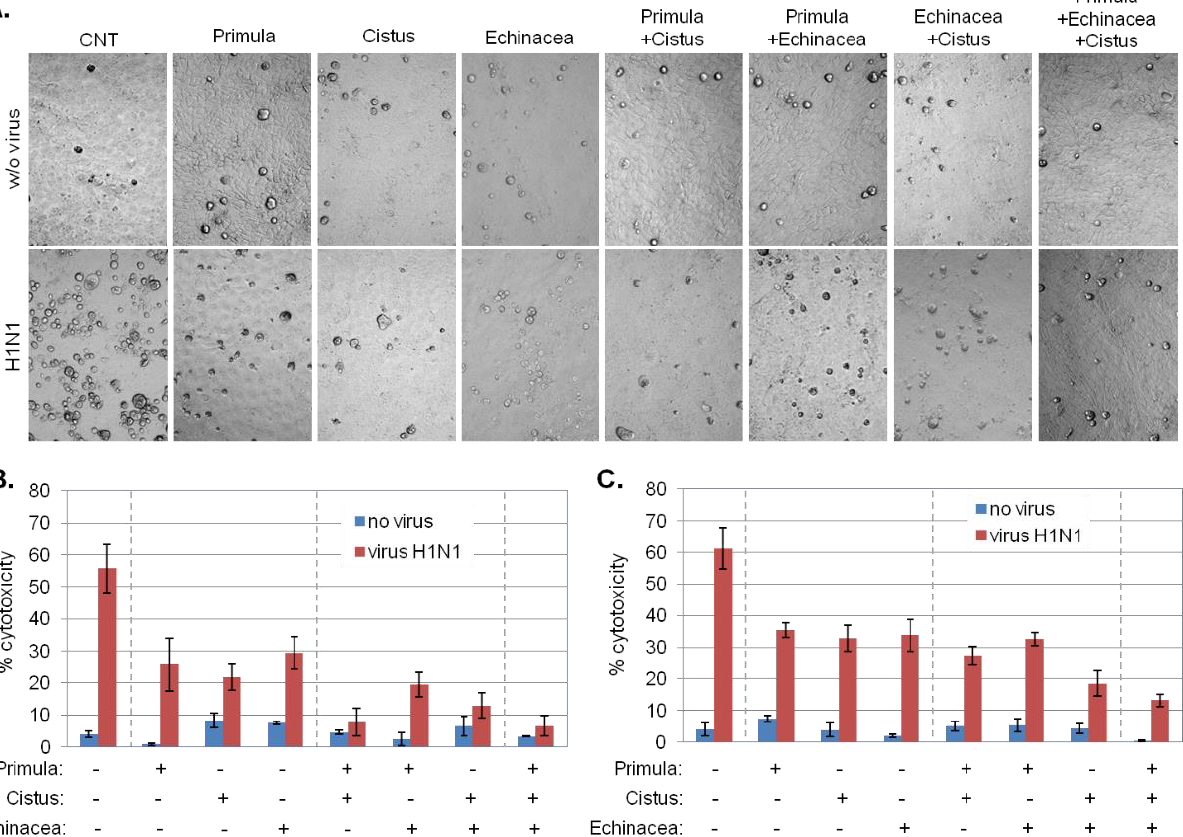
Figure 5. Therapeutic effects of P. veris extracts on influenza virus-induced cytolysis. ( A ) Microphotographs of MDCK cells infected with H1N1 (MOI = 0.2) followed by 24 h treatment with 50 μg/mL Primula (supercritical CO 2 + 13% EtOH), Echinacea (EtOH/H 2 O-Xad7-derived), Cistus (hydroethanolic) extracts and their combinations. Rounded cells are indicative of virus-induced cytotoxicity. CNT: control cultures which were either remained uninfected (w/o virus) or infected with H1N1 in the absence of further treatment. ( B , C ) Collective data of virus-induced MDCK cell lysis, assessed by LDH release assays, following infection with either H1N1 in the presence or absence of 50 μg/mL ( B ) or 25 μg/mL ( C ) Primula, Echinacea, Cistus extracts and their combinations, as indicated. Data are the average of duplicate determinations from 3 independent experiments.